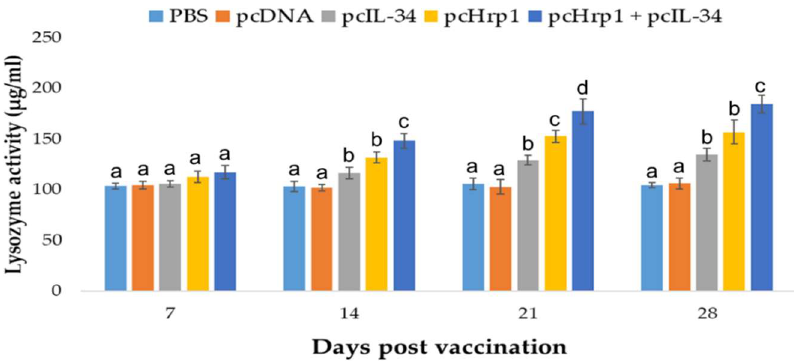
Figure 8. Serum lysozyme activity of vaccinated fish. Largemouth bass were vaccinated with PBS, pcDNA3.1, pcIL-34, pcHrp1 and pcHrp1 + pcIL-34, respectively. Sera were collected from 7 days to 28 days post-vaccination. Data are presented as means ± standard deviation (SD) (n = 5). a,b,c,d A significant difference ( p < 0.05) exists between groups at the same time point with different superscript letters.